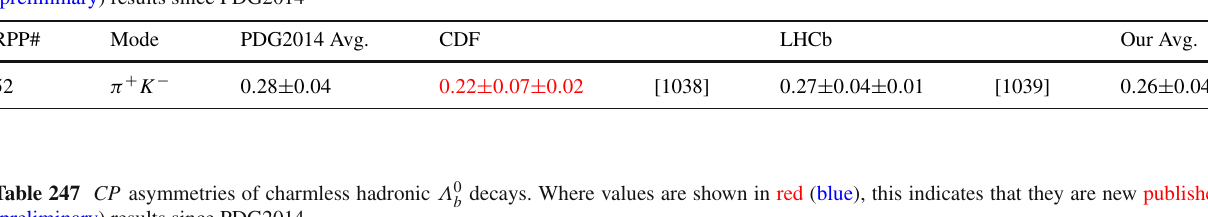
decays. Where values are shown in red (blue), this indicates that they are new published b